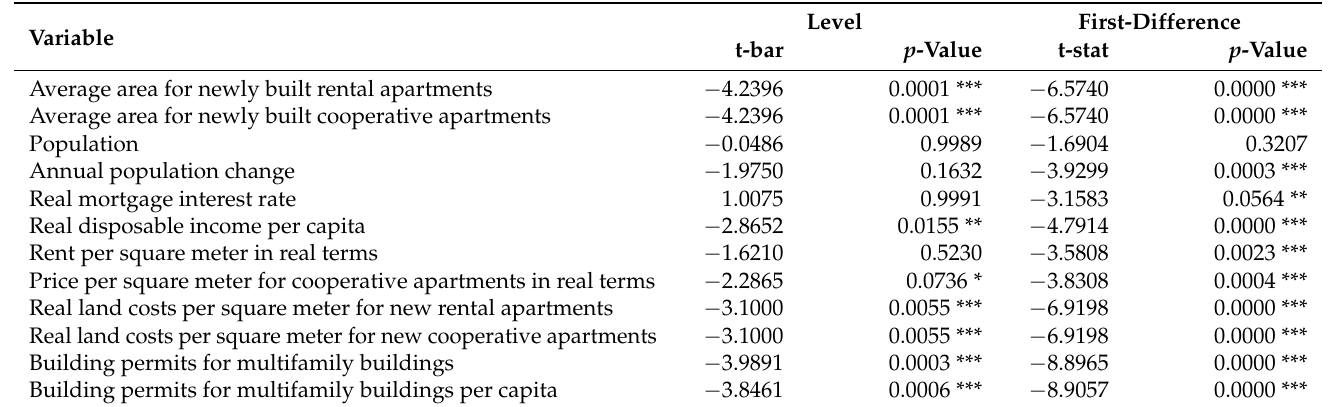
Figure 13. Number of building permits for construction of multifamily buildings in the three largest urban areas in Sweden issued as follows: ( a ) total number of apartments to be constructed; ( b ) total number of apartments to be constructed per capita. Table 3. Stationarity test for variables transformed to natural